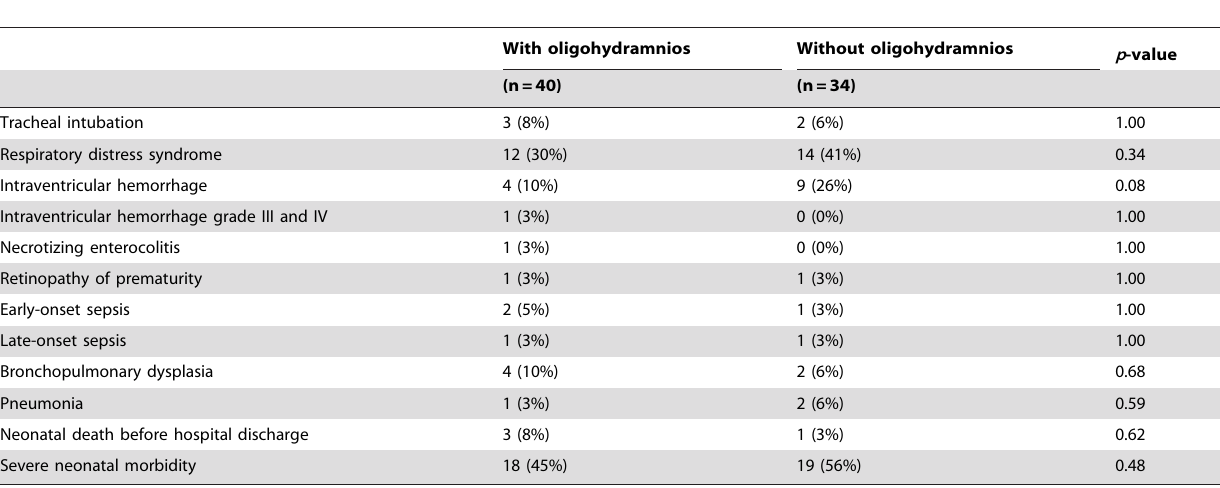
Table 2. The presence and absence of oligohydramnios with respect to the presence of selected conditions of severe neonatal morbidity.